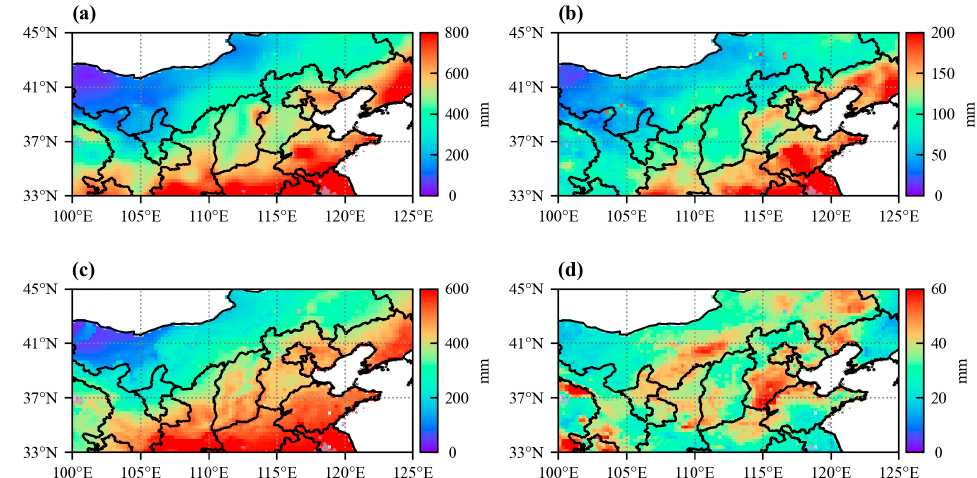
Figure 3. Spatial distribution of ( a ) climatology of annual precipitation, ( b ) standard deviation of annual precipitation, ( c ) climatology of evapotranspiration, and ( d ) standard deviation of evapotranspiration in the climate transitional zone of northern China.